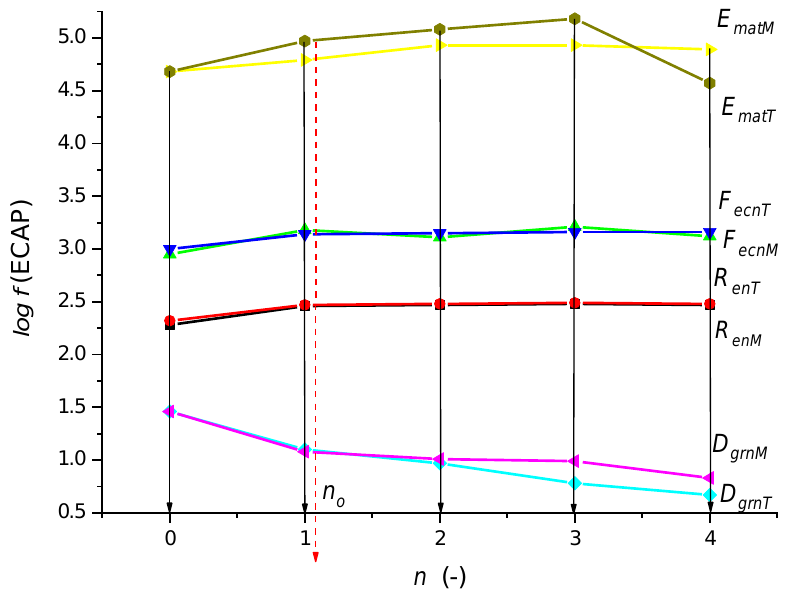
Figure 15. Comparison of measured and theoretical values for n = 1 to n = 4 extrusions (Table 3). According to the graph in Figure 15, for all the compared functions, there is a mini- mum difference between the measured and theoretical values. This fact justifies accepting the proposed and newly developed theory and offering it for use in laboratory and tech- nical practice.